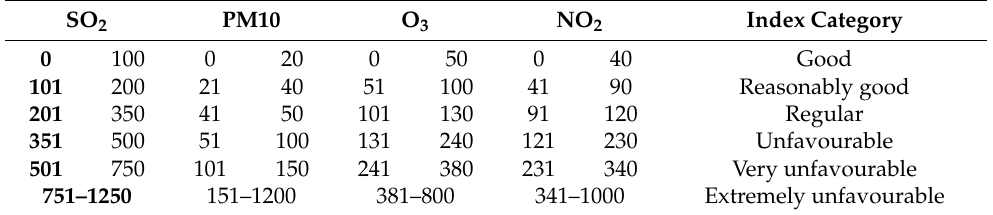
Table 3. Air quality index Category [64].